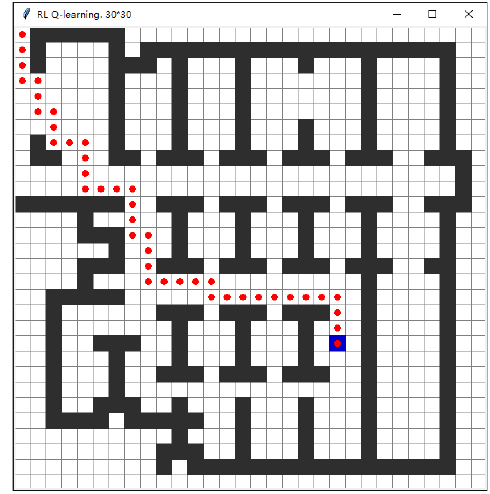
Figure 11. Fire-free environment path planning.